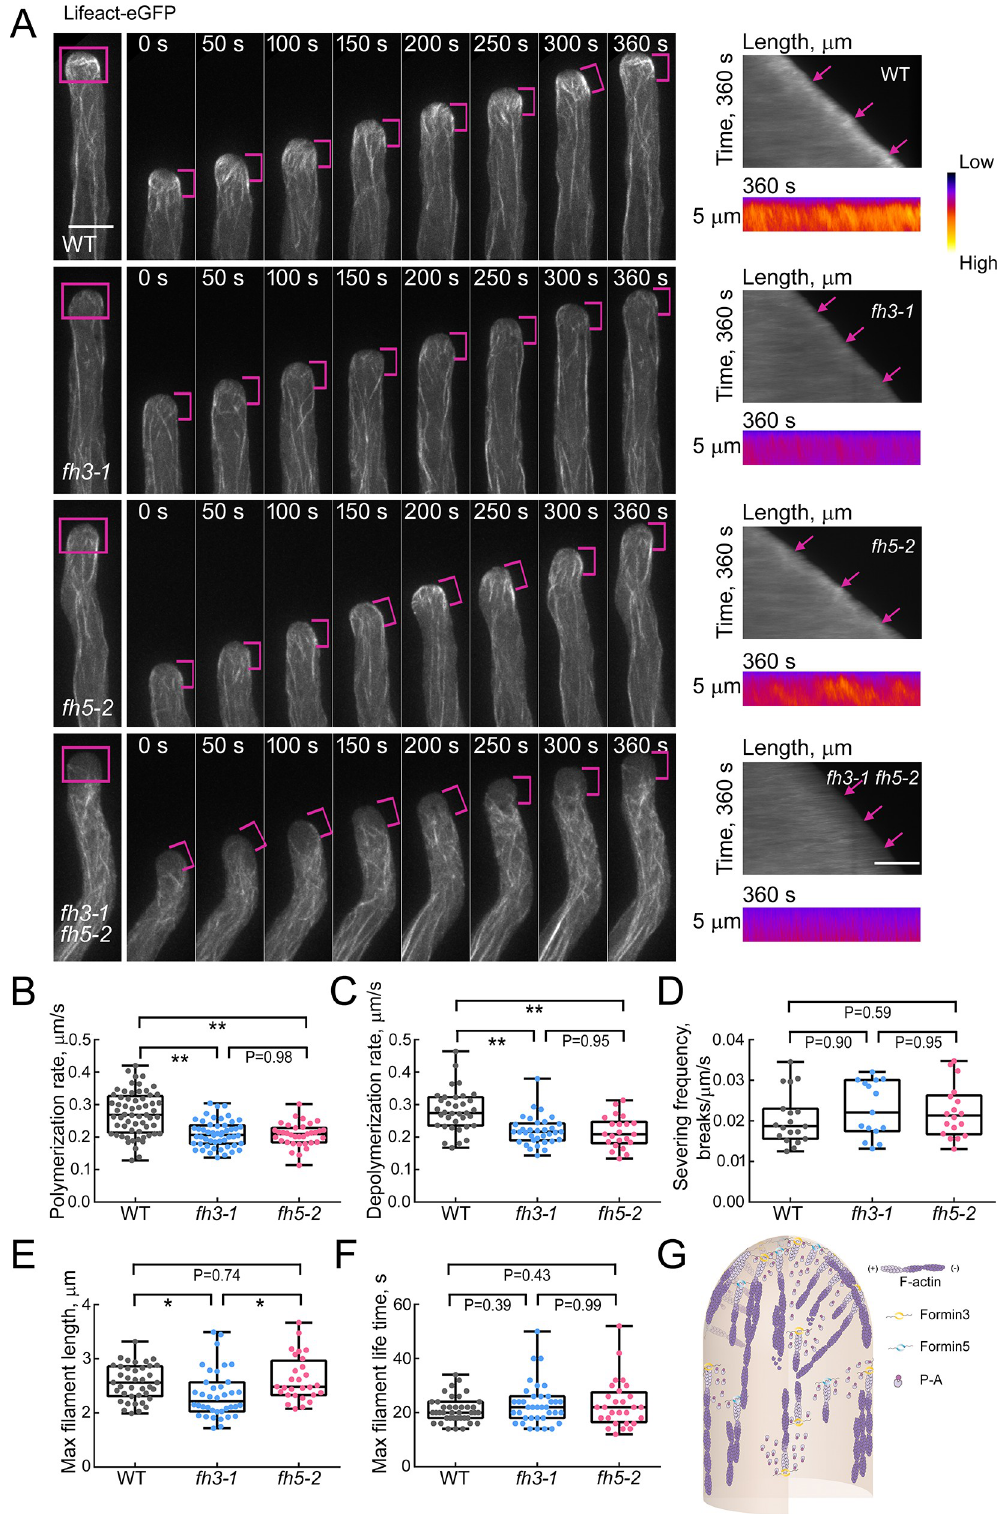
Fig 5. Apical actin polymerization is impaired in formin loss-of-function mutant pollen tubes. ( A ) Time-lapse images of actin filaments in growing WT and fh3-1 , fh5-2 and fh3-1 fh5-2 mutant pollen tubes. The left panels (labeled 0–360 s)